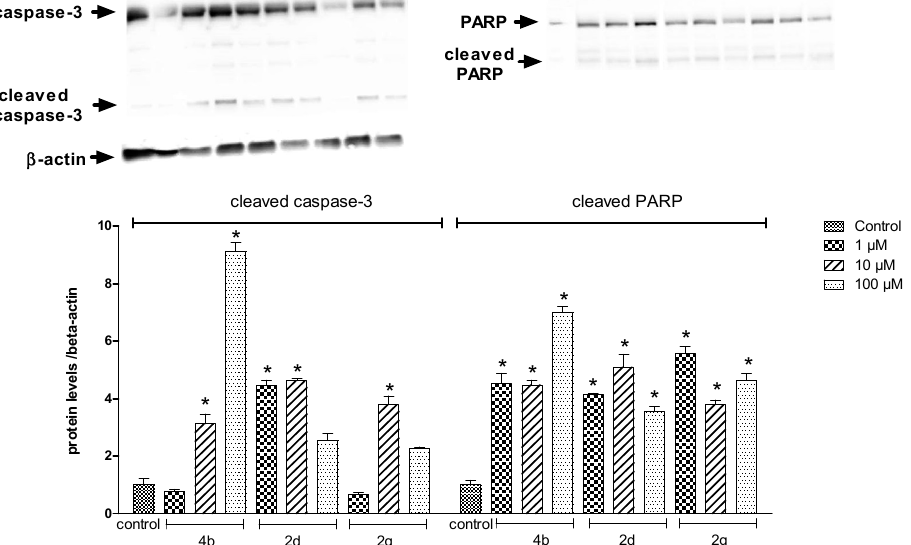
Figure 5. Changes in cleaved caspase-3 and cleaved PARP protein levels. Representative Western blots showing protein expressions of full-length or cleaved caspase-3 and PARP following treatments of compounds 2d , 2g and 4b at 3 concentrations (1, 10 and 100 µ M). Graphs indicate the relative densitometric values of the proteins. Quantification of protein product was performed by densitometric scanning. Data were normalized by using the β -actin signal and are expressed as arbitrary densitometric units. Values are means SD; n = 5 in each group. * p < 0.01 significant difference from the control group.